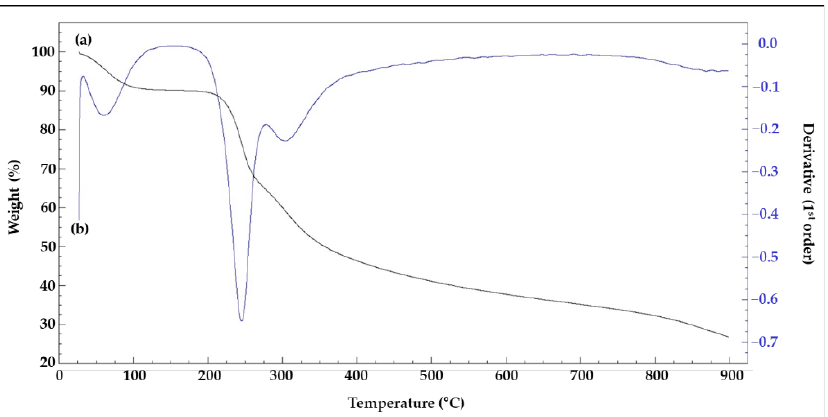
Figure 5. TGA analysis of purified lyEPS produced after 7 days of incubation of Lysobacter sp. MMG2 in tryptic soy broth supplemented with 1% glucose. ( a ) TGA and ( b ) DTA of lyEPS.